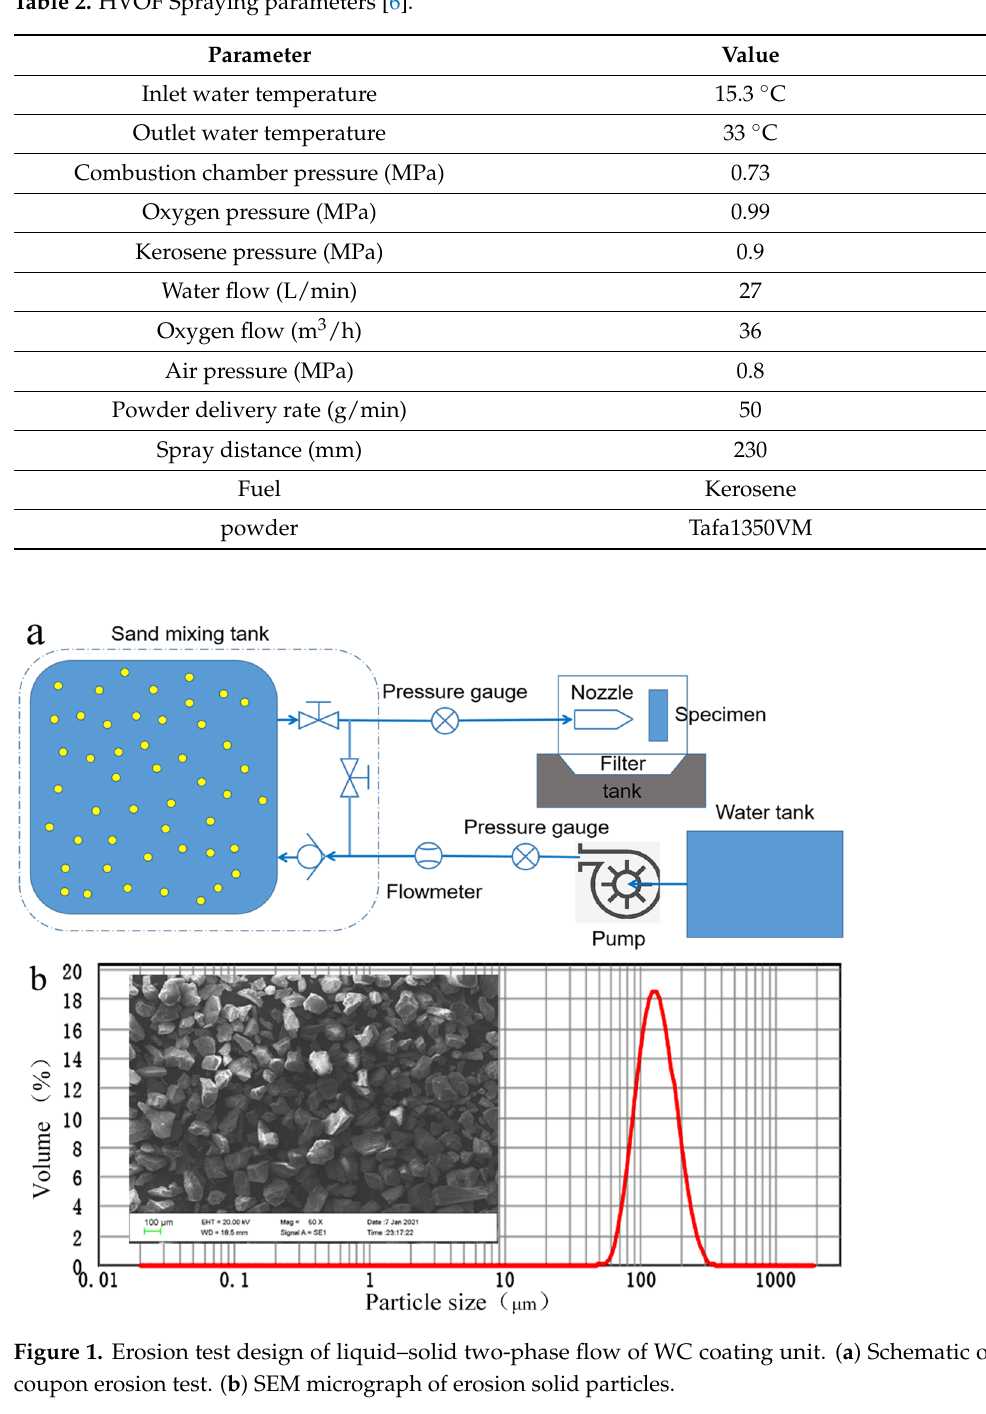
Table 2. HVOF Spraying parameters [6].